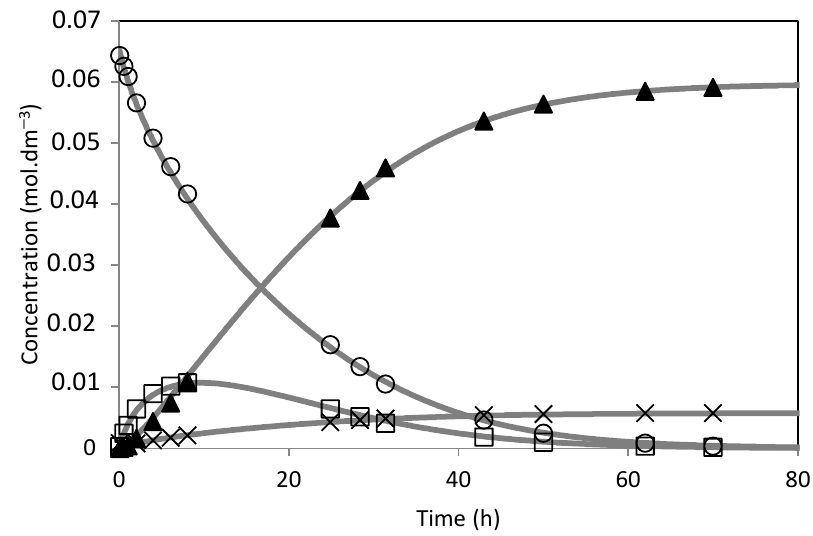
Figure 18. Camphene hydration over PW4‑SBA‑15‑SO 3 H catalyst. ( # ) Camphene; ( □ ) Camphene hydrate; ( ▲ ) Isoborneol; ( × ) Others. The lines represent the model fitted to the experimental points.